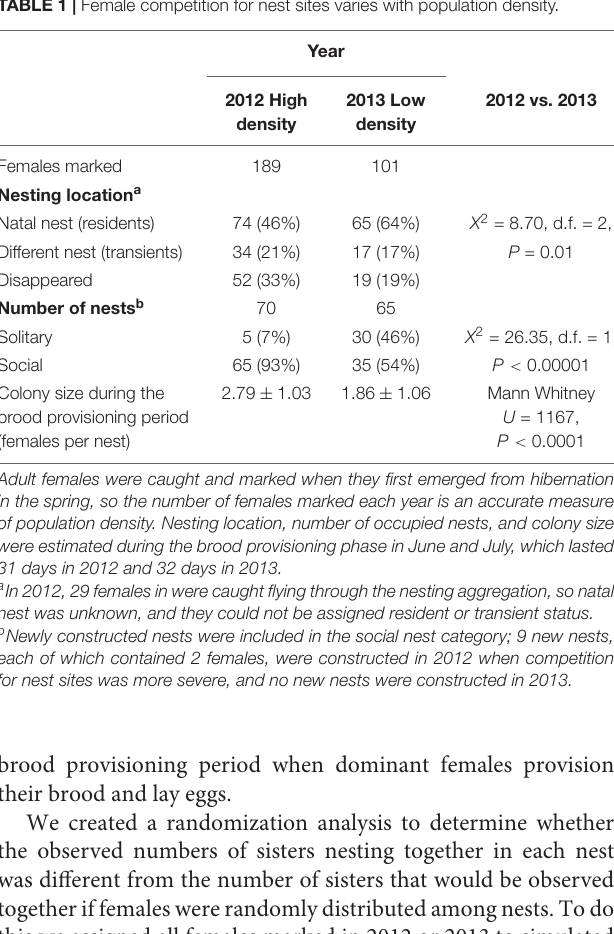
TABLE 1 | Female competition for nest sites varies with population density.